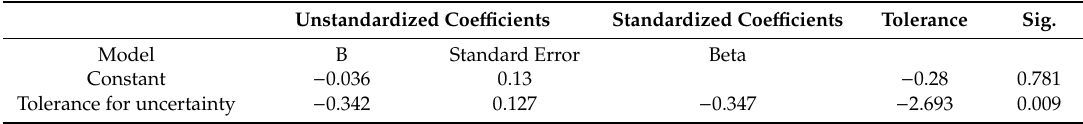
Table 3. Regression model parameters for the preferred orientation level (POL).